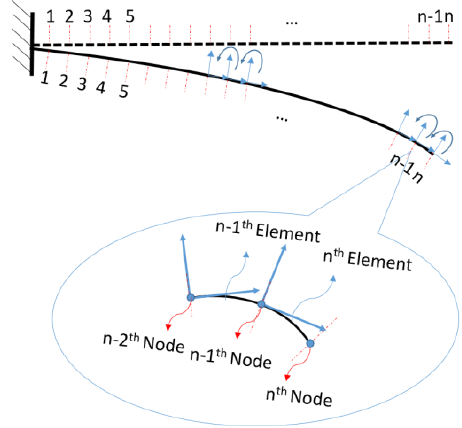
Figure 8. Element map for the coordinate transformation method.